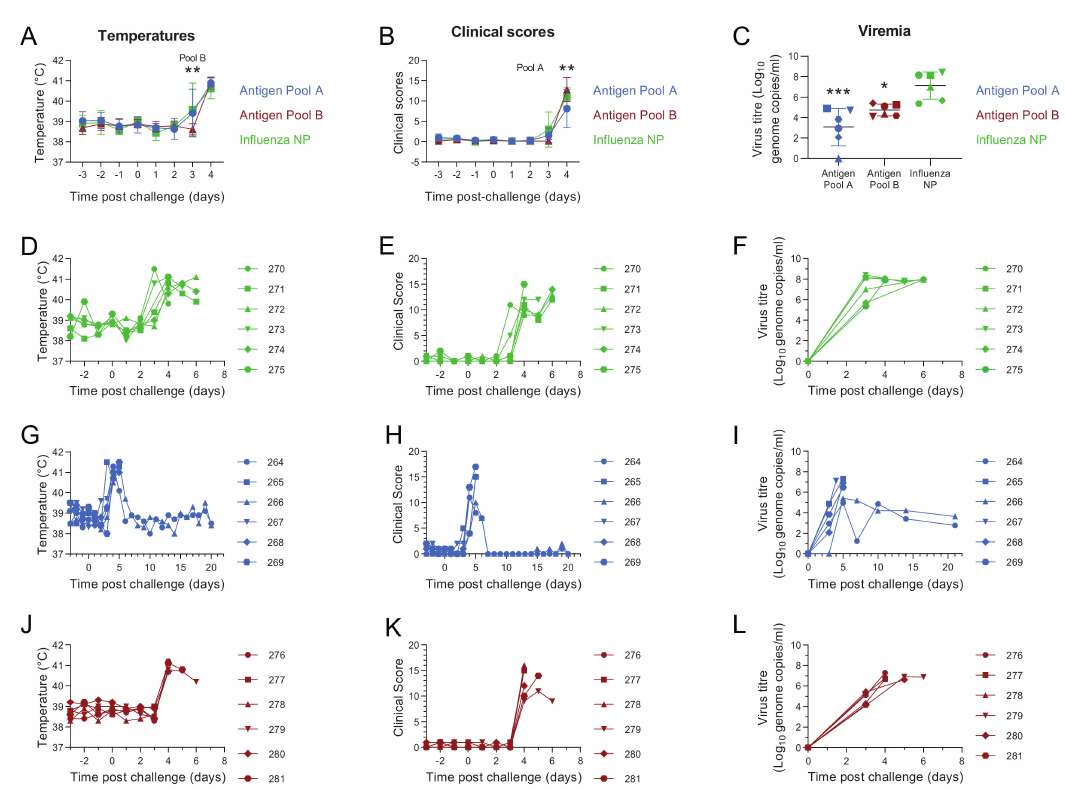
Figure 4. Clinical and virological parameters in experiment 1. Mean temperatures ( A ), clinical scores ( B ) up to four days and viremia three days post-challenge ( C ) of groups of six pigs primed and boosted with Antigen Pool A (blue), Antigen Pool B (red) or influenza NP (green). Temperatures ( D , G , J ) and clinical scores ( E , H , K ) for each individual pig immunized with influenza NP ( D , E ), Antigen Pool A ( G , H ) or Antigen Pool B ( J , K ) are shown. Blood was taken from animals immunized with Influenza NP ( F ), Antigen Pool A ( I ), Antigen Pool C ( L ) on the indicated days and DNA was extracted in duplicate and the viral titer determined by qPCR, with each extraction tested in duplicate. Data points are the mean of the duplicate extractions. Errors bars on panels A, B and C indicate standard deviation from the mean. Asterisks on panels B and C show significant di ff erences in the indicated group of pigs compared to the control. Temperatures and clinical scores were assessed by repeated-measures two-way ANOVA, * p ≤ 0.05, ** p ≤ 0.01 or *** p ≤